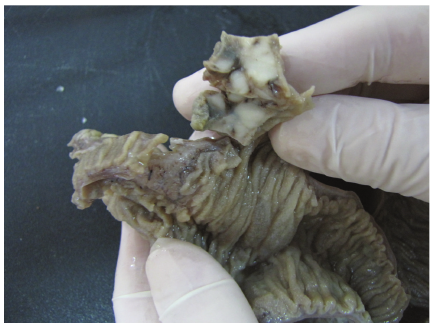
Figure 1: Grossly secondarily ulcerated solid nodular gray white tumor